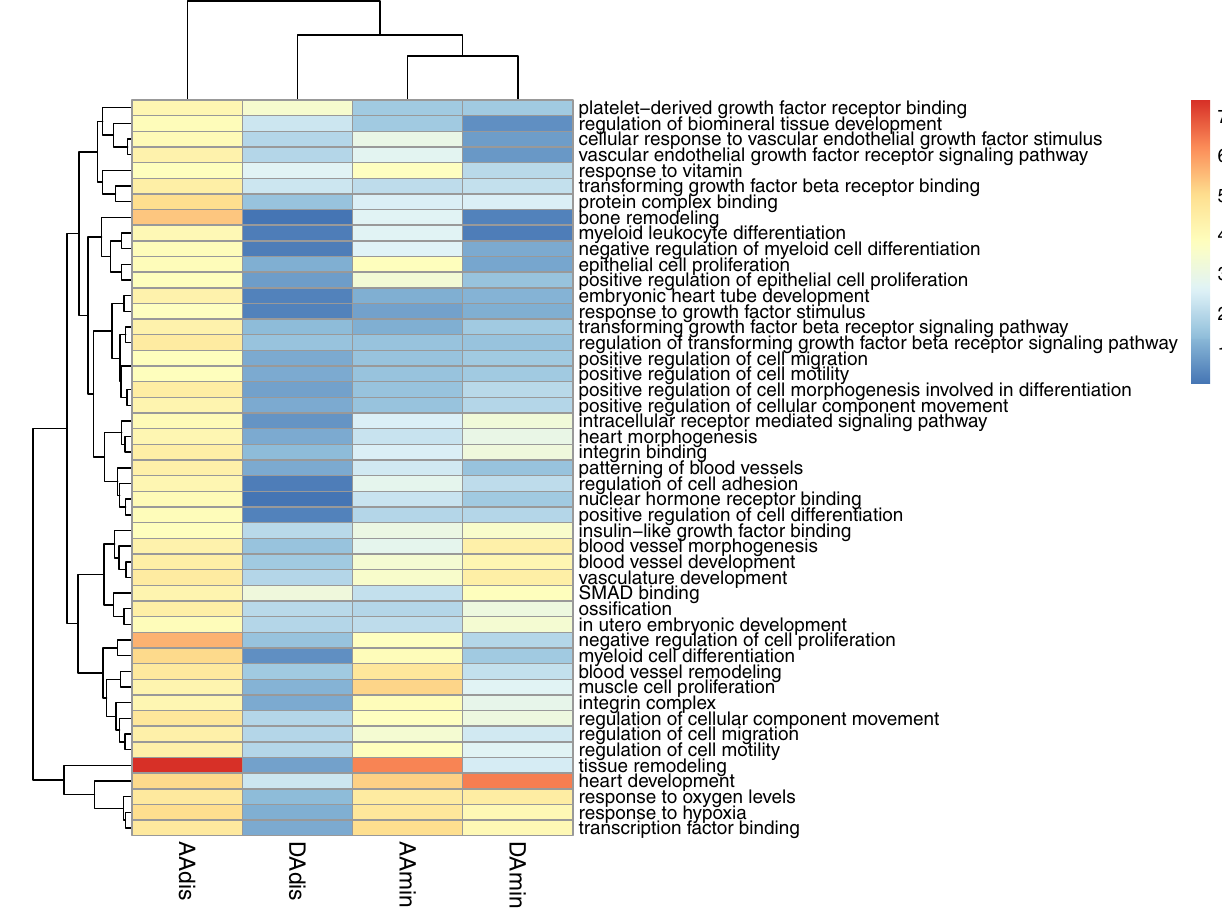
Fig. 2 | Heatmap of signi fi cantly enriched gene ontologies (GO terms) for minimum area and distensibility phenotypes generated by DEPICT. Colour scale denotes the signi fi cance of enrichment, (unadjusted p value − log10 scale). Only GO terms signi fi cantly enriched in association with AAdis (FDR<0.01) are